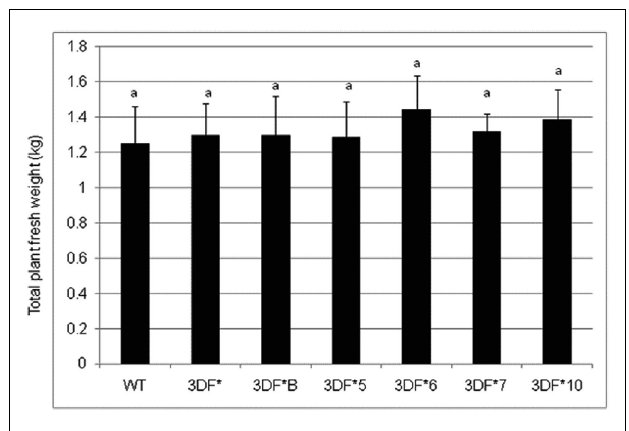
FIGUREA1 |The total fresh weight of fea1 -transformed cassava and wild-type (WT) cassava plants. The plants were grown in the greenhouse for 6months.Three independent replicates of wild-type and transformed plants were used in the analysis. *Numbers with same letters show no statistical difference, different letters mean statistical difference at 95% confidence level.